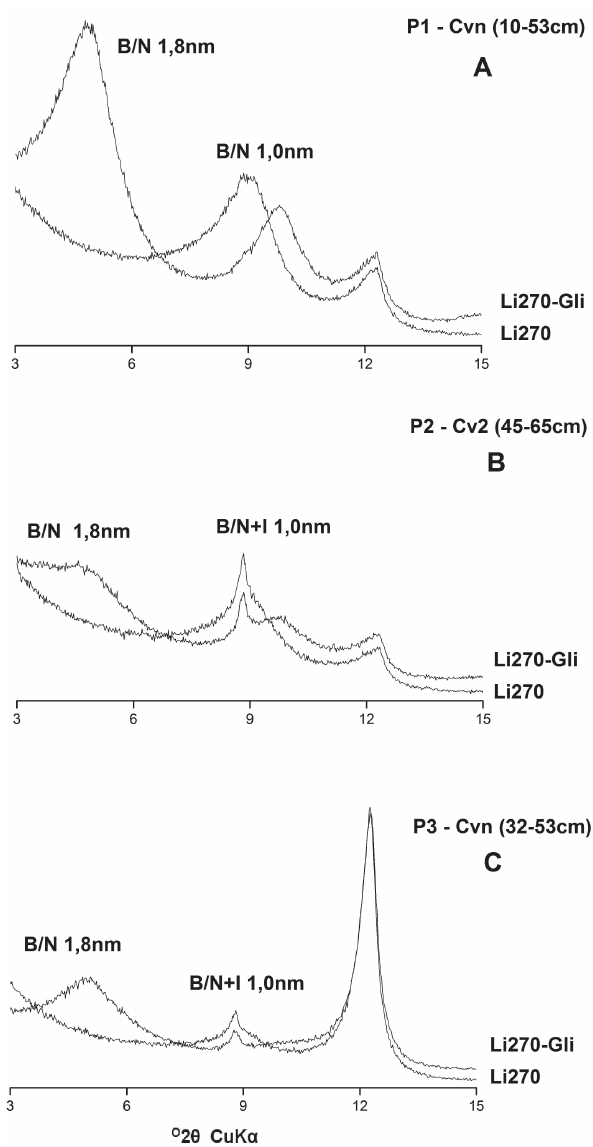
Figura 6. Difratogramas de raios-X da fração argila dos horizontes vérticos dos perfis de Fernando de Noronha, PE, submetidos ao teste de Greene- Kelly (B/N-beidelita/nontronita; e